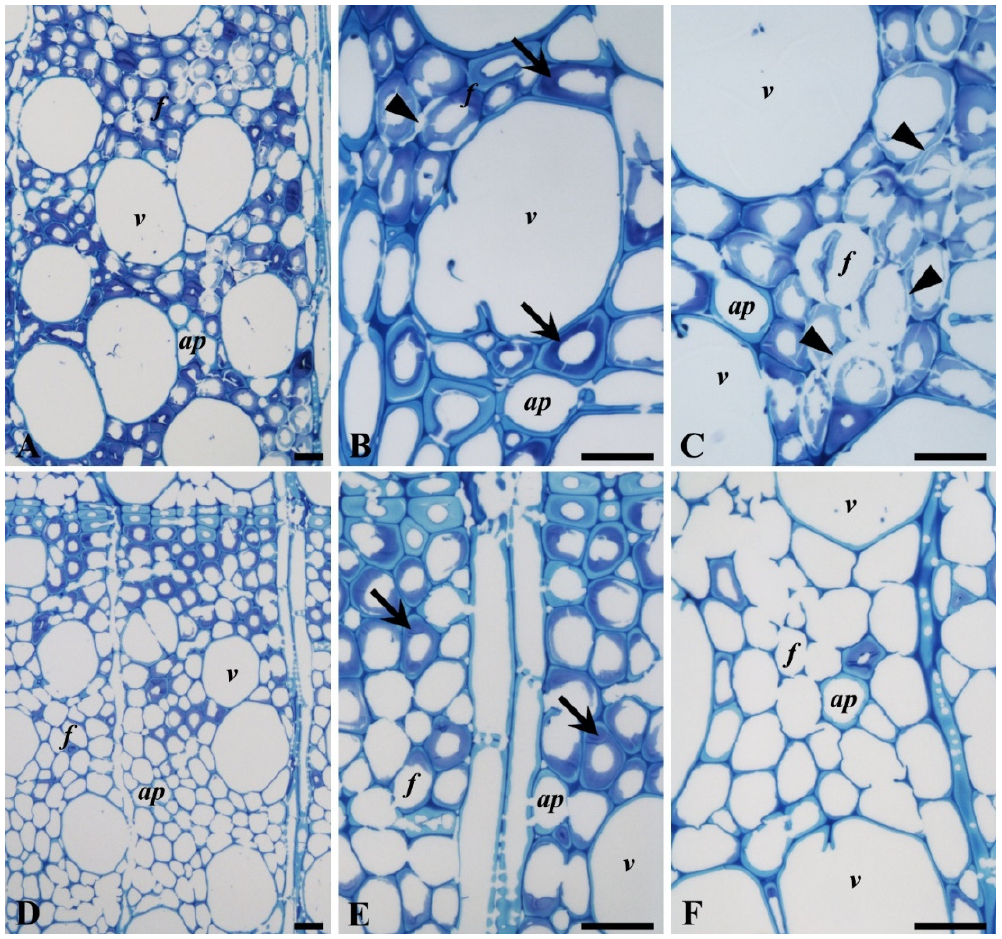
Figure 8. LM observations of beech wood decayed by P. ostreatus and T. versicolor . The beech wood observed showed the presence of gelatinous fibers (arrows in B , E ). ( A – C ) Decay by P. ostreatus showing fiber degradation by thinning of the cell wall from the lumen outwards. Note degradation of the middle lamella (ML) regions prior to complete degradation of the fiber secondary cell wall (arrowheads in B , C ). ( D – F ) Decay by T. versicolor showing advanced stages of decay in fibers by thinning cell walls from the lumen outwards. Note, degradation of ML regions of fibers, with only remaining middle lamella cell corner (MLcc) regions ( F ). Degradation of the vessel ( v ) and axial parenchyma cell ( ap ) was less significant than fibers ( F ). Scale bars: 20 µm.